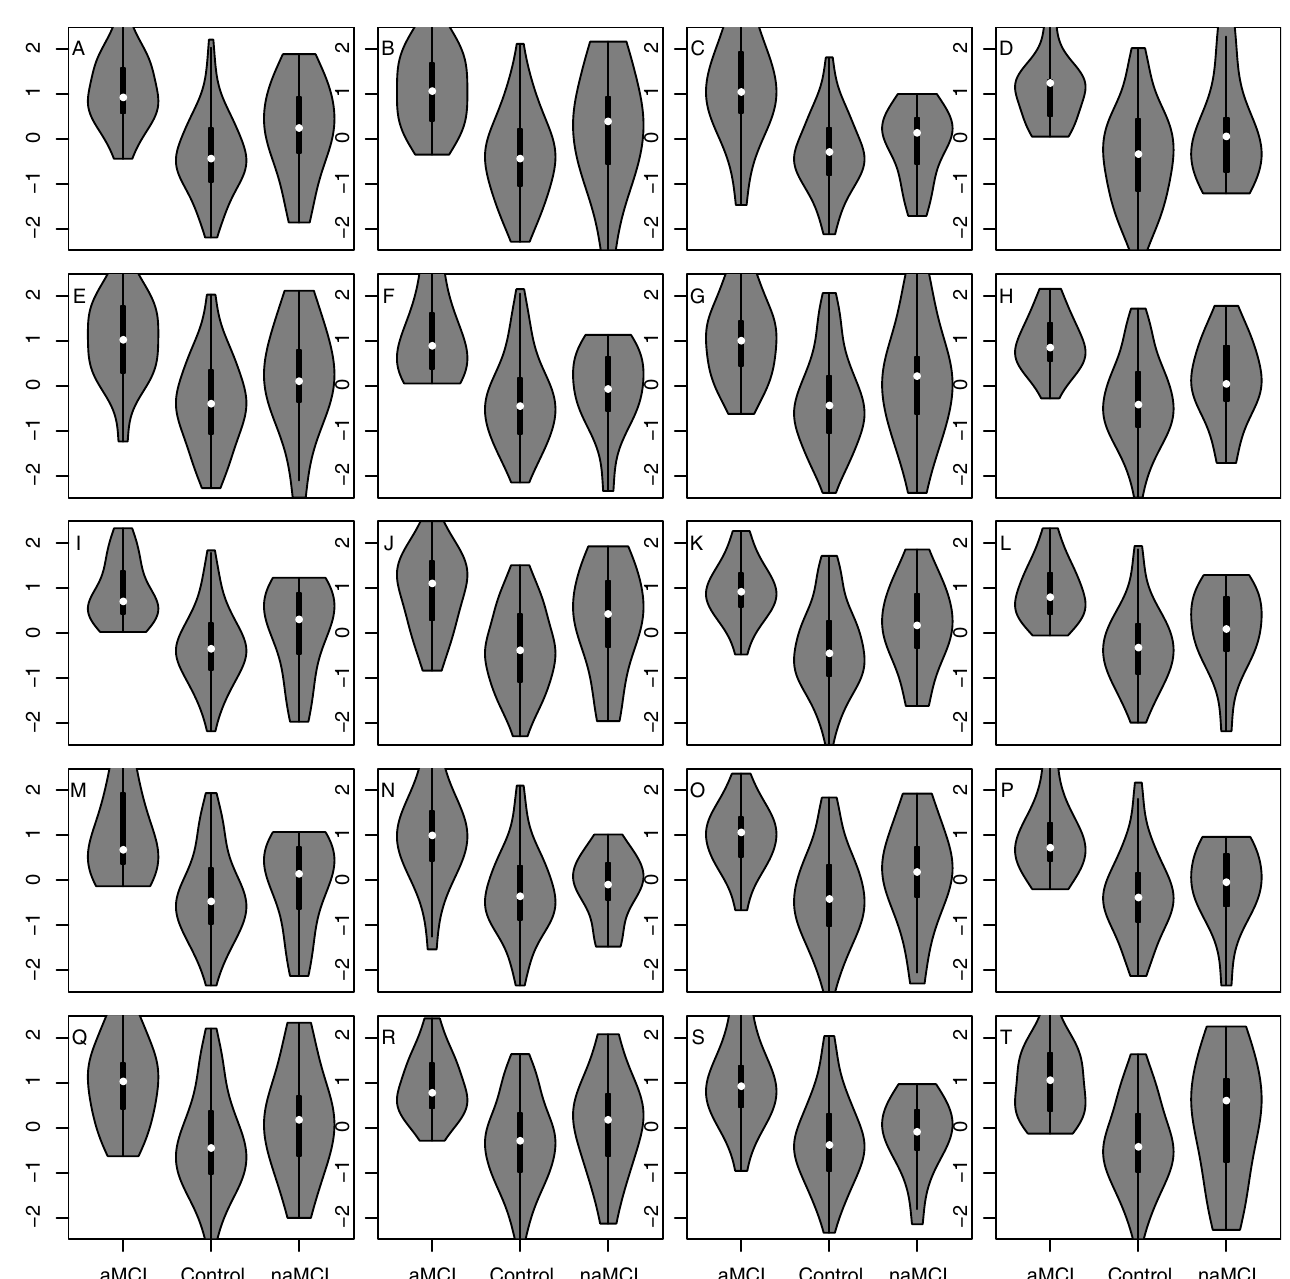
Fig 2. Contrasts of speech or language features from Table 3 with the 20 most significant p-values for association with aMCI or HC cohort membership are displayed with violin and embedded box plots. The corresponding p-values are in Table 3. No contrasts had false discovery rates below 0.5 for association with naMCI versus HC cohort membership. The plots are in the same alphanumeric order as the rows in Table 3, with panel A showing the distribution across cohorts of values for the difference of quantile normalized values of Count of modals minus Count of prepositions, and subsequent panels for contrasts with increasing p-values. A: Count of modals minus Count of prepositions. B: Count of modals minus Count of RELATED content units. C: Pro-sentences minus Count of prepositions. D: Count of modals minus Count of indefinite articles. E: Count of modals minus Count of nouns. F: Pro-sentences minus Count of RELATED content units. G: Count of modals minus Both Sides Total Content Units DISTINCT. H: Count of modals minus Count of words. I: Syllables per word min minus Count of DISTINCT RELATED content units. J: Count of modals minus Count of content units on RIGHT side of picture. K: Count of modals minus Count of Syllables. L: Syllables per word min minus Count of RELATED content units. M: Pro-sentences minus Count of DISTINCT RELATED content units. N: Pro-sentences minus Count of Syllables. O: Count of modals minus Count of ALL content units. P: Pro-sentences minus Count of nouns. Q: Count of modals minus Both Sides Total Content Units. R: Count of modals minus Count of ALL DISTINCT content units. S: Pro-sentences minus Count of ALL content units. T: Count of modals minus Count of DISTINCT RELATED content units.